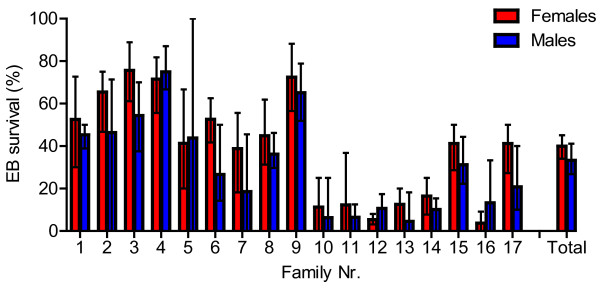
Gender specific survival ratios in the EB trial. Survival ratios (%) for females and males, presented by family 1 to 17 and for all individuals, as ‘Total’. Results are averaged over the four replicate tanks, whiskers at min and max values.